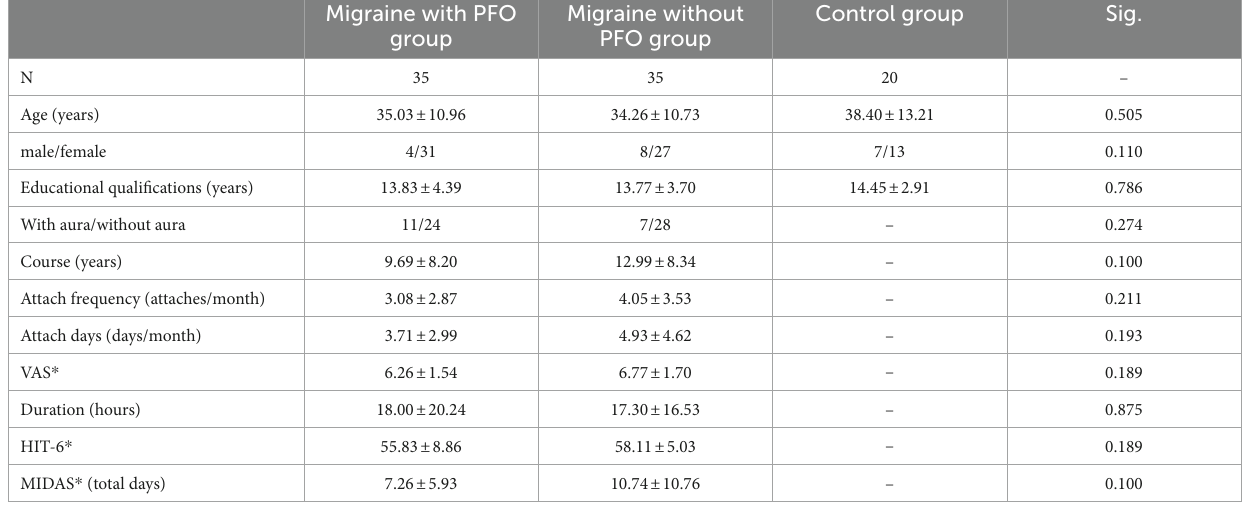
TABLE 1 Clinical characteristics of three groups.